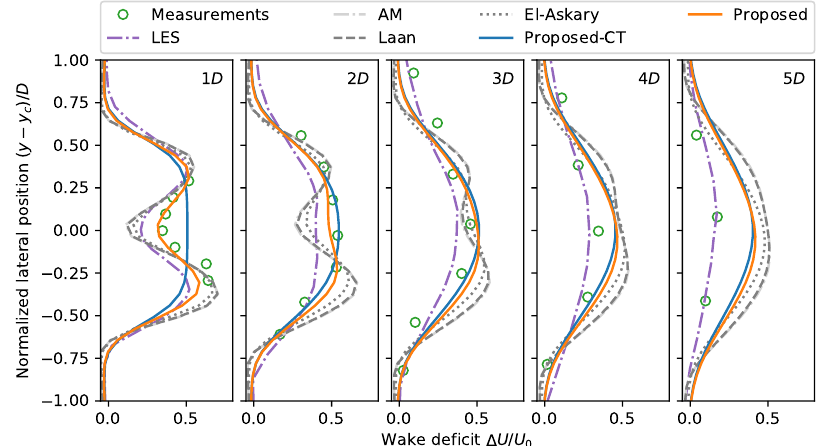
Figure 13. Lateral wake deficit of a NTK500/41 wind turbine at hub height under the stable condition; ∆ U is the velocity deficit in the wake and U 0 is the inlet velocity.